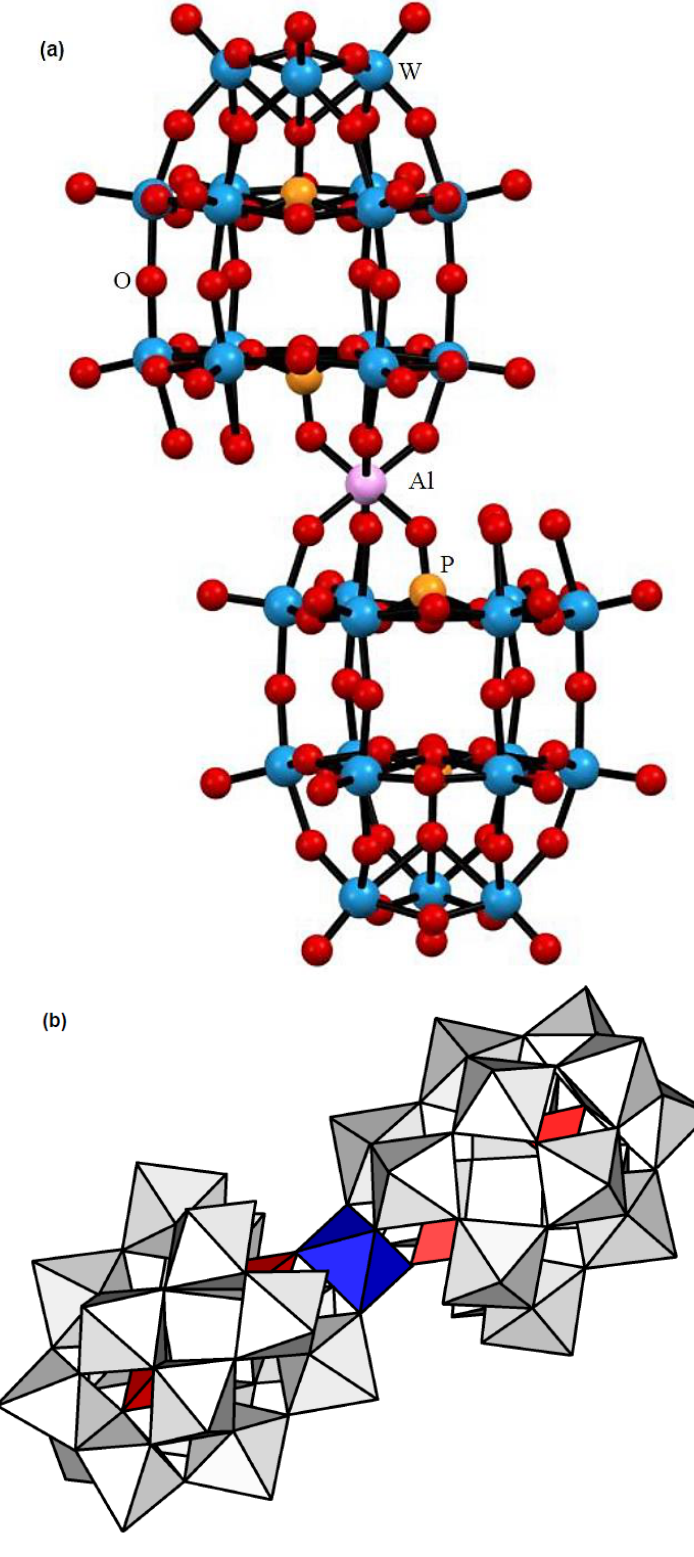
Figure 1. ( a ) Molecular structure (ball and stick representation) and ( b ) polyhedral representation of the polyoxoanion [H 14 Al(B- α -P 2 W 15 O 56 ) 2 ] 7 − (1). In the polyhedral representation, the AlO 6 , WO 6 , and internal PO 4 groups are represented blue and white octahedra, and red tetrahedra, respectively.